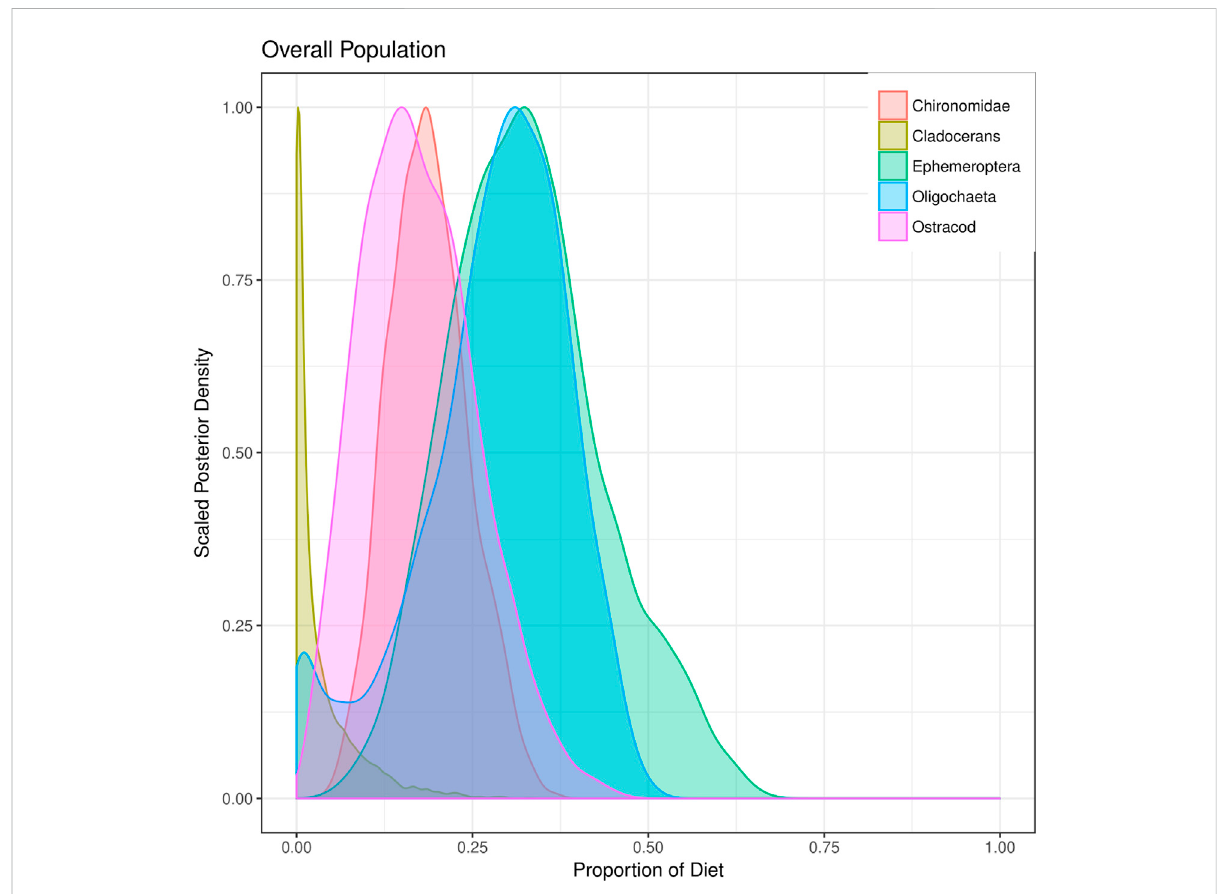
FIGURE 3 An example of the graphical output provided by the MixSIAR package, which shows the posterior density distributions of each prey item consumed by Eastern Sand Darter in the Thames River, Ontario, Canada estimated in Burbank et al.